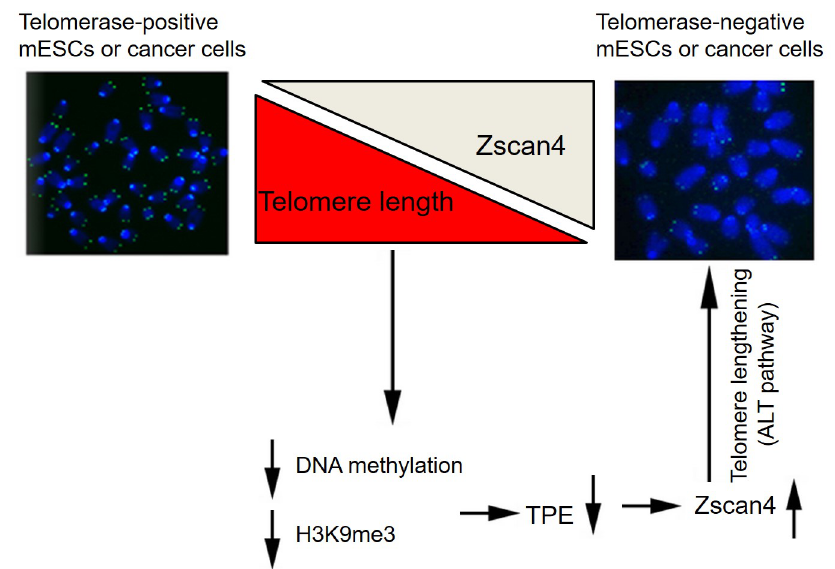
Figure 7. Proposed model of telomere length homeostasis shared in telomerase-deficient late genera- tion mESCs and ALT-U2 OS cells. The telomerase-deficient mouse ES cells and ALT-U2 OS cancer cells share similar mechanisms to maintain telomere homeostasis. Zscan4 is activated due to reduced TPE associated with shortened telomeres at subtelomeric Zscan4 loci in those cells. The up-regulation of Zscan4 activates ALT mechanisms, ensuring telomere homeostasis and the capacity of those cells to proliferate for many passages without telomerase